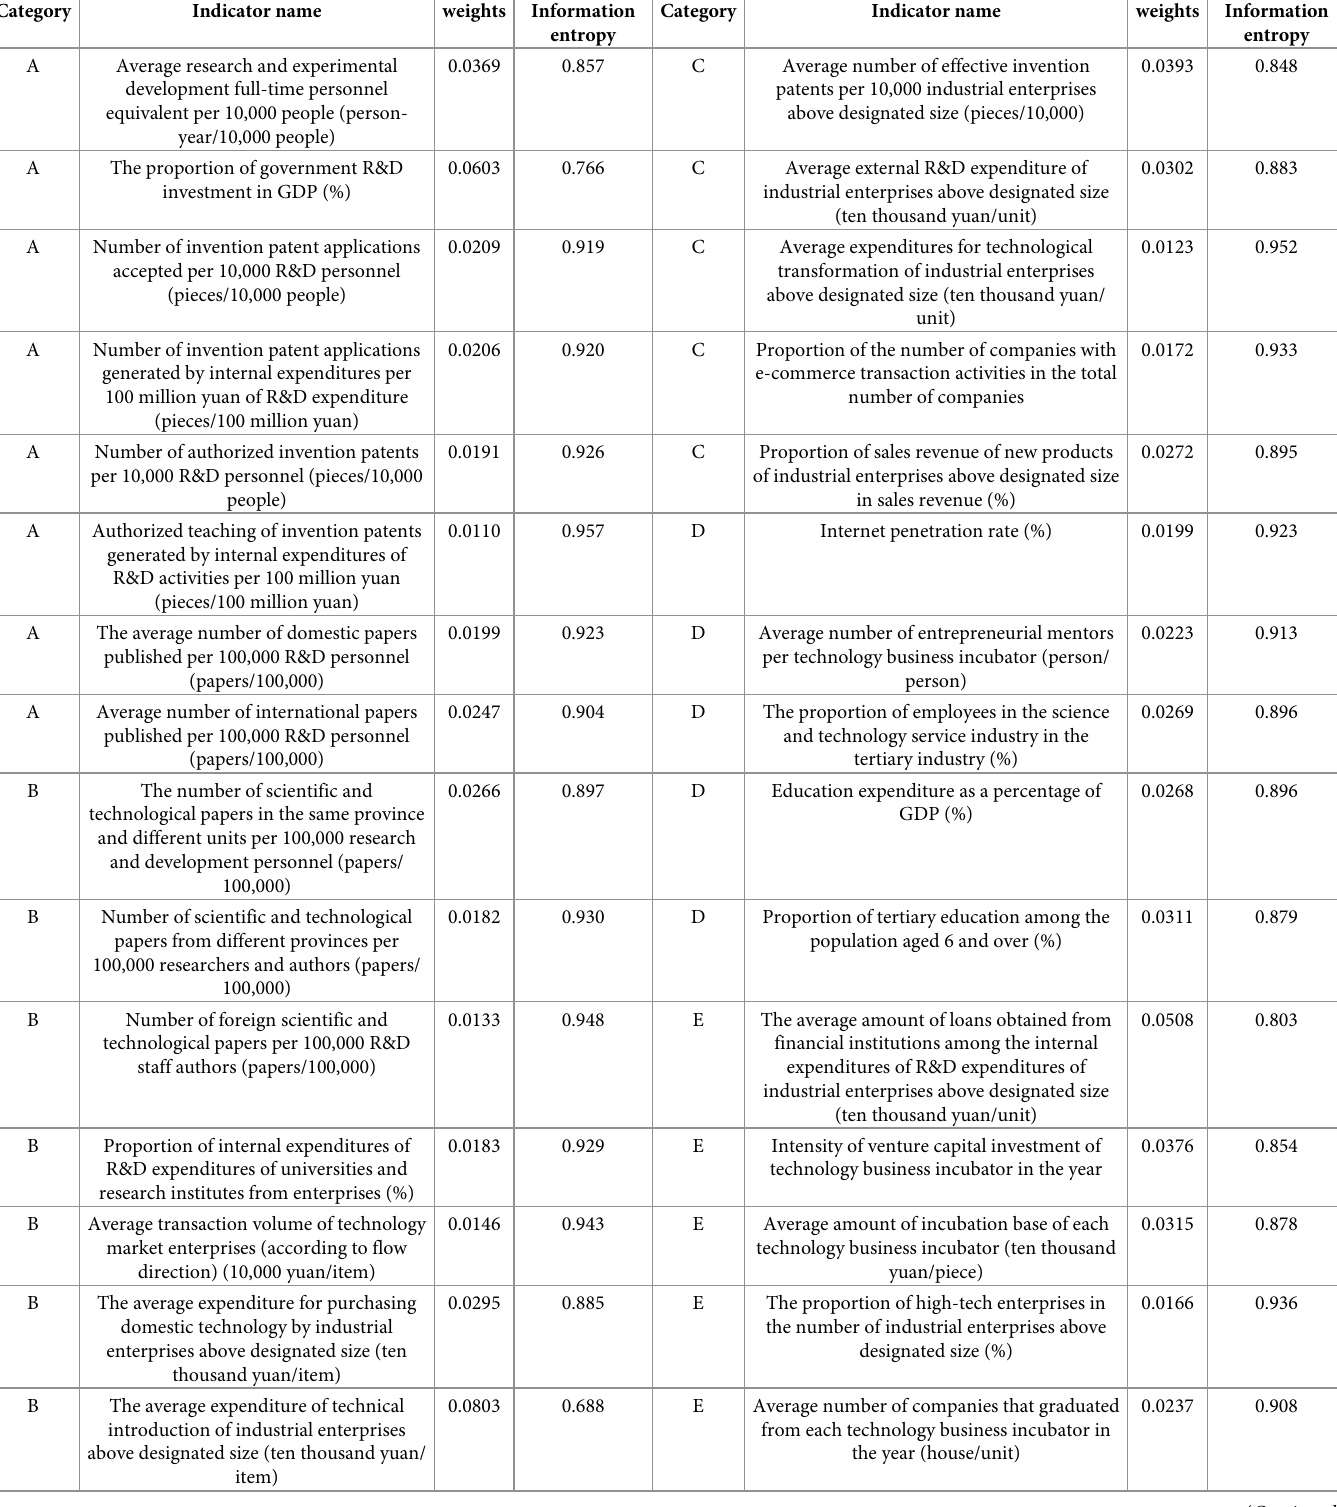
Table 1. Indicators and weights related to innovation